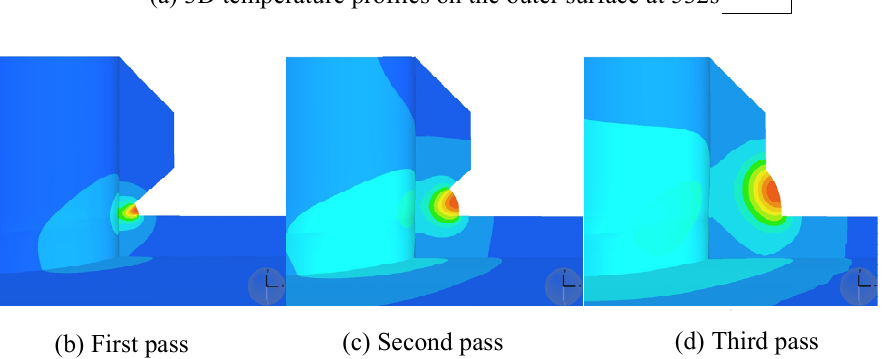
Figure 11. Three-dimensional (3D) temperature profiles.